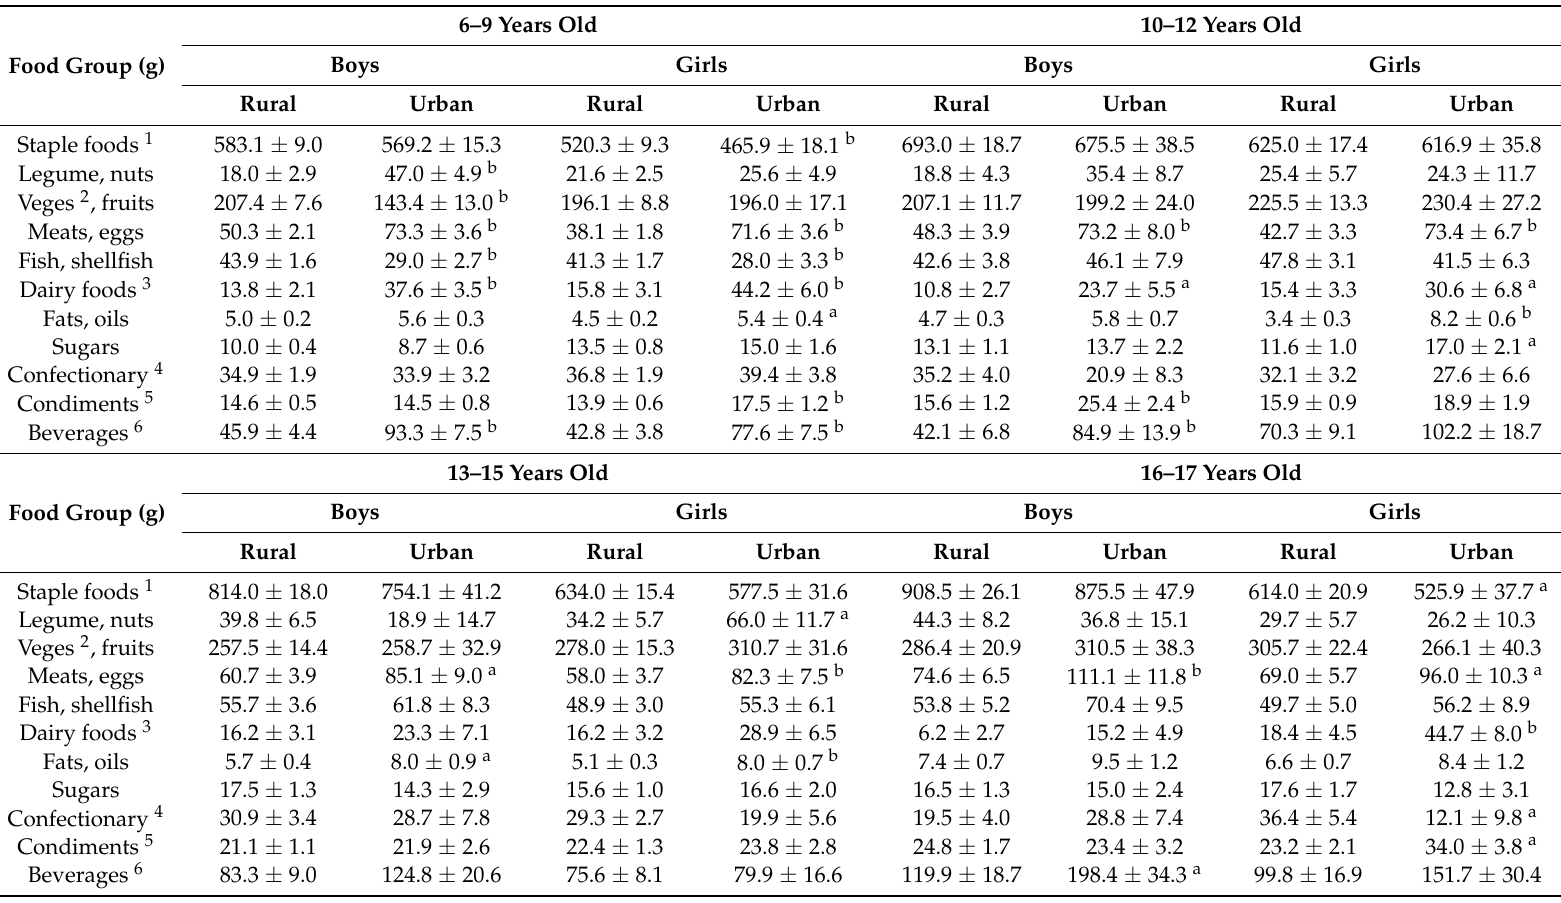
Table 5. Intake of food groups by age group and the area of residence (mean values ± standard errors) † .